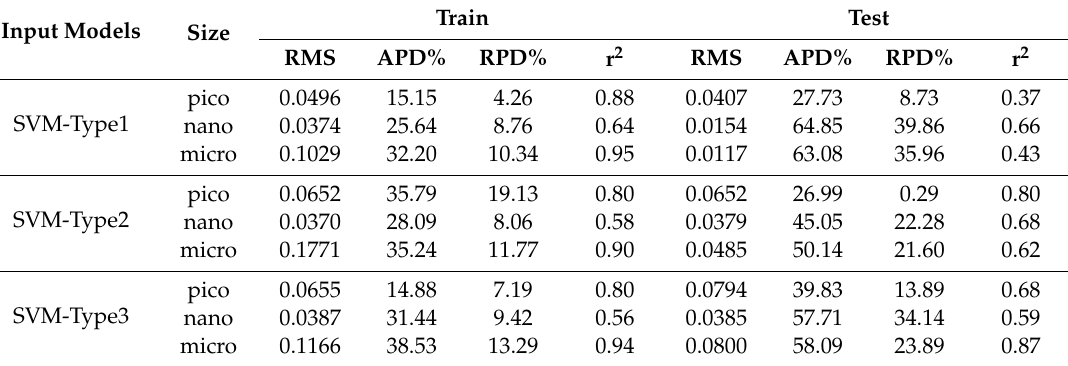
Figure 4. Boxplot of retrieved PSCs for three inputs (red, green, and blue represent SVM-Type1, SVM-Type2, and SVM-Type3, respectively) for ( a ) the training dataset and ( b ) the test dataset. Table 2. Statistical parameters of PSCs derived from PSC models using three inputs.